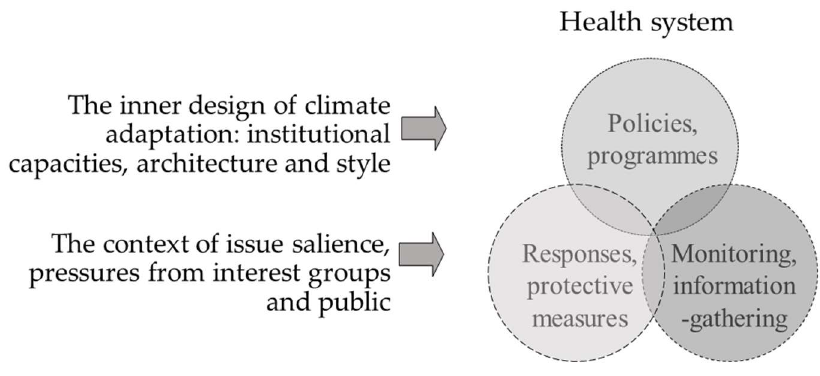
Figure 1. Determinants of climate adaptation of health systems.